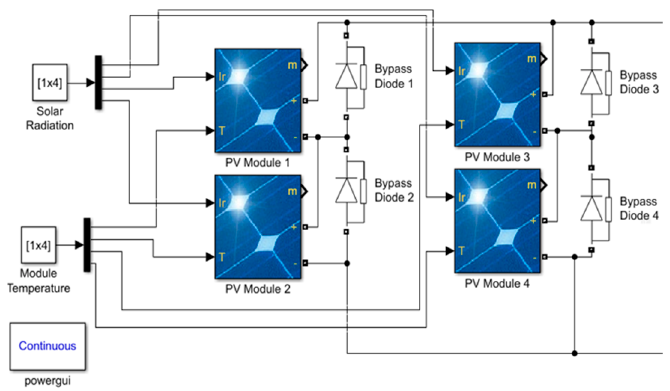
Figure 1. The PV configuration used in MATLAB (Source: Authors).